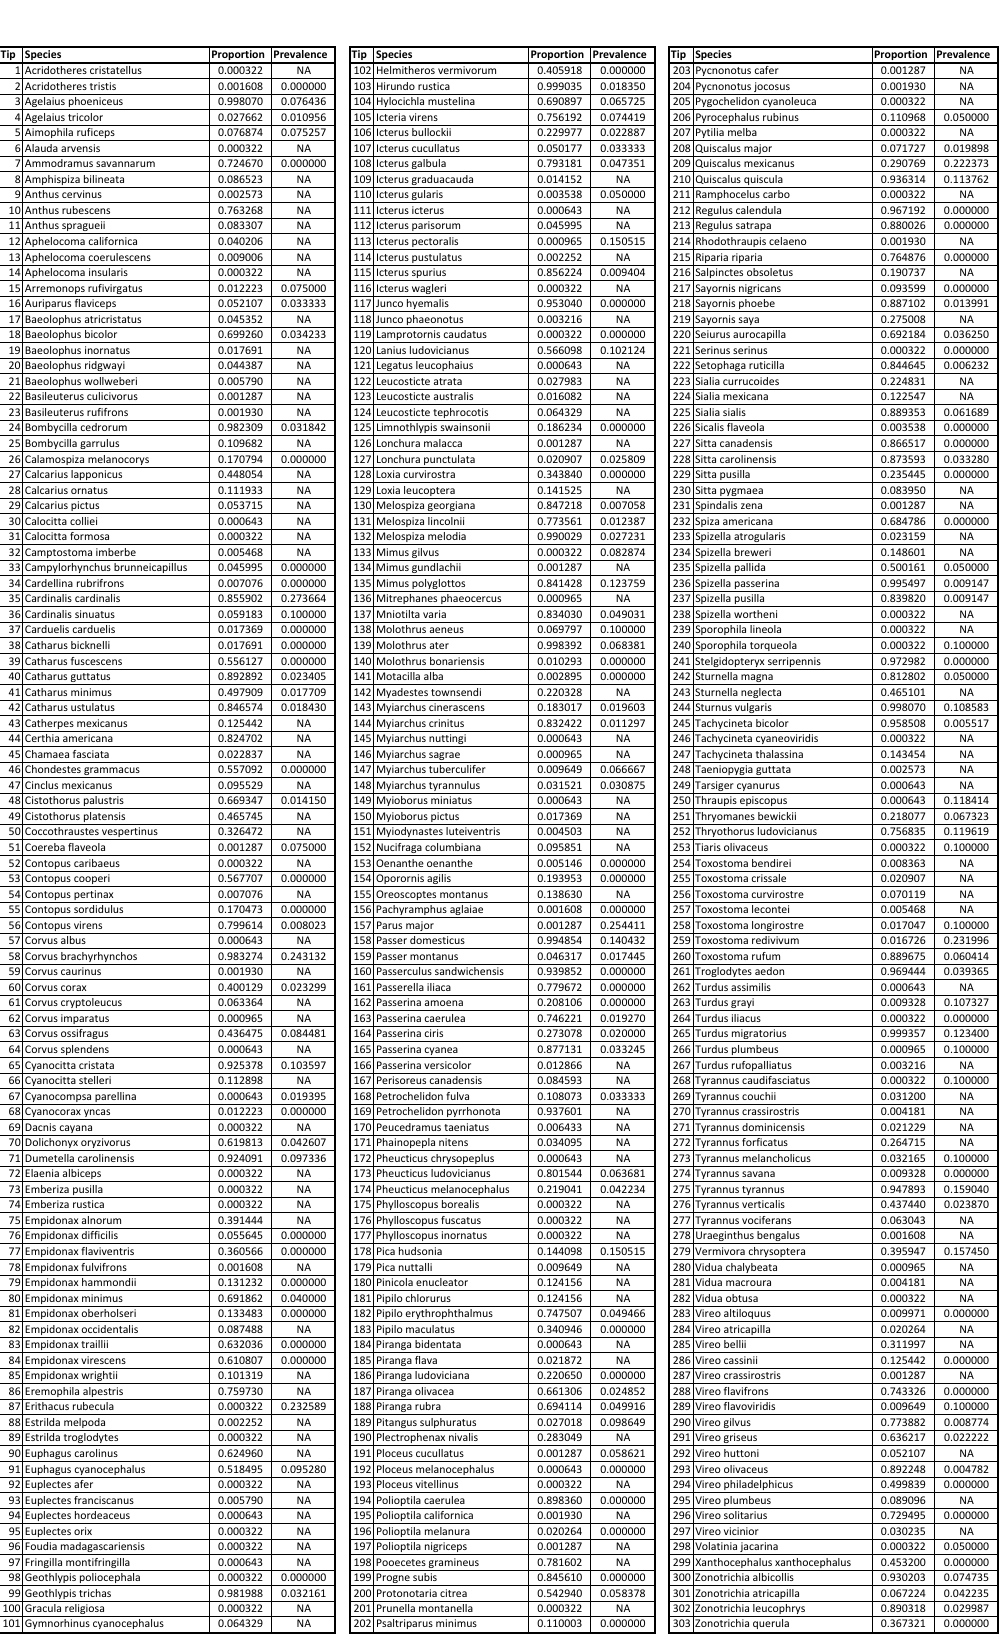
Figure A3. Detailed metadata for WNV avian host phylogenetic tree (Figure 3). Columns list the tree tip number (Tip), species name (Species), the proportion of occupied counties (Proportion), and estimated WNV prevalence for each avian